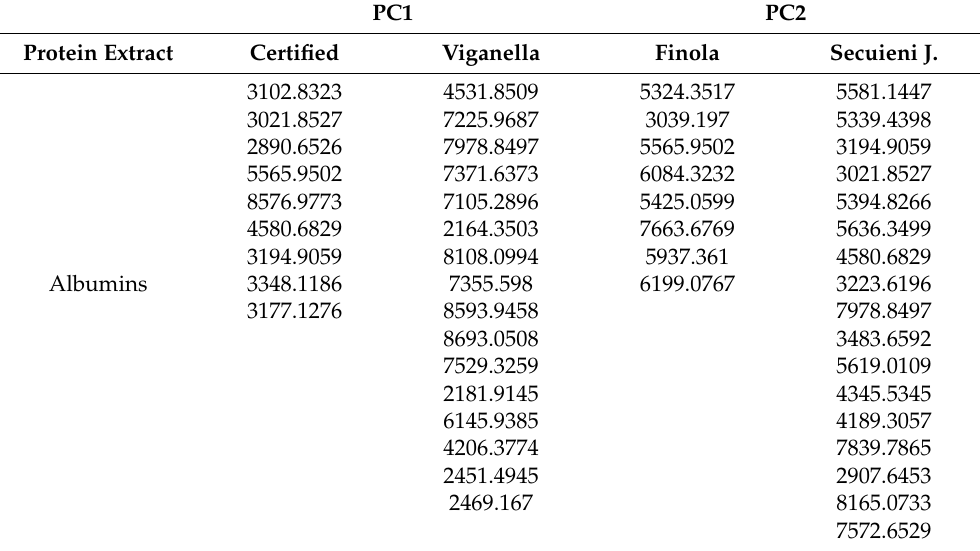
Table 6. Mass signals from albumin and globulin extracts corresponding to the top 25 loadings on PC1 and PC2 indicating their correlation with seed origin (certified vs. Viganella) and variety (Finola and Secuieni J.), respectively.